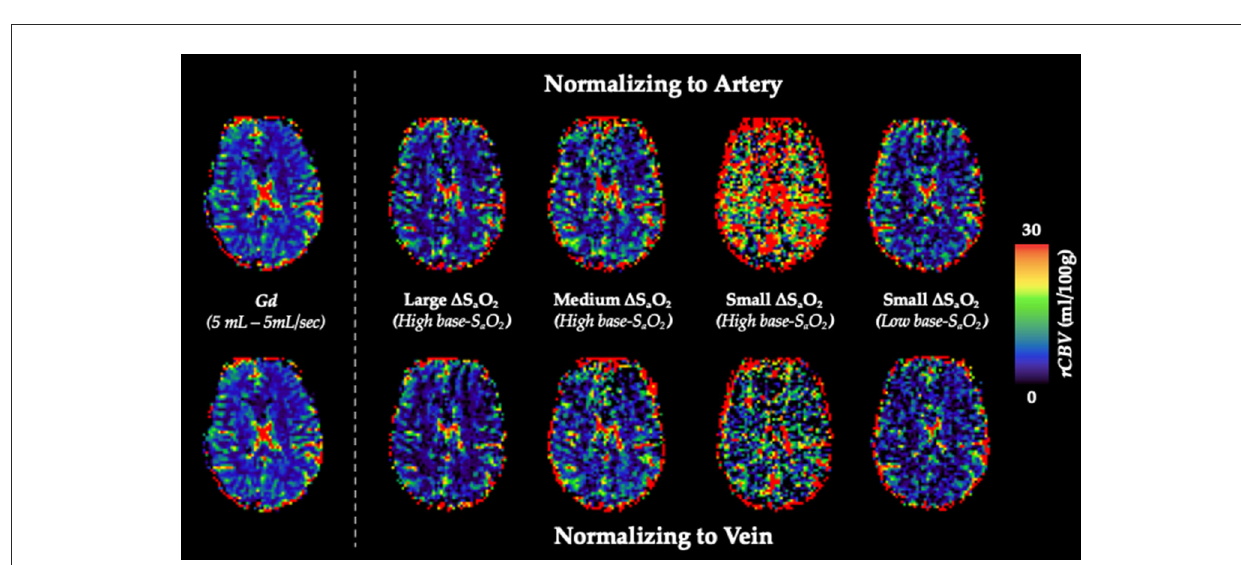
FIGURE5 rCBV Dependency on 1 S a O 2 and Base-S a O 2 . Top (Arterial Normalization) . rCBV (mL/100g) maps from representative subject axial slice where tissue is normalized to an arterial voxel in the MCA for five subsequent paradigms (left to right): standard Gd, large 1 S a O 2 with high base-S a O 2 , medium 1 S a O 2 with high base-S a O 2 , small 1 S a O 2 with high base-S a O 2 , small 1 S a O 2 with low base-S a O 2 . Bottom (Venous Normalization) . rCBV (mL/100g) maps from representative subject axial slice where tissue is normalized to a venous voxel in the SSS for the same paradigms.